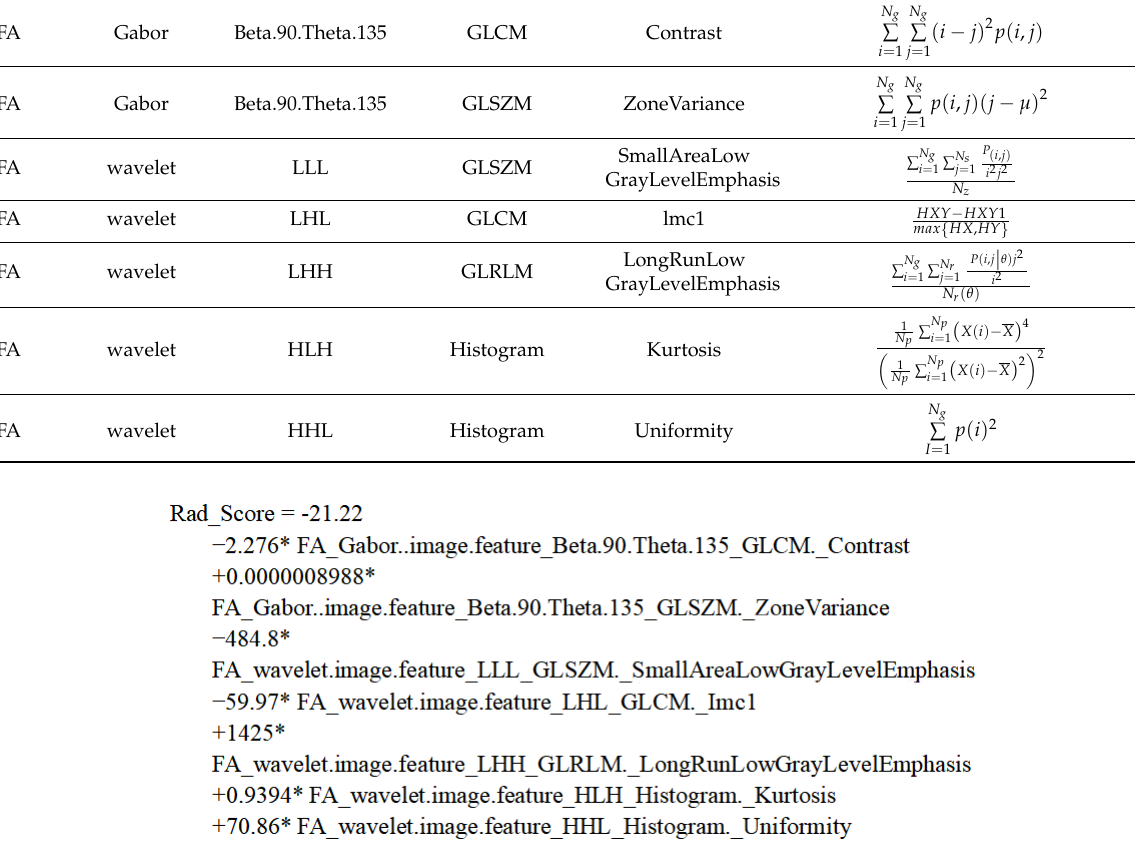
Figure 4. Formula of radiomic